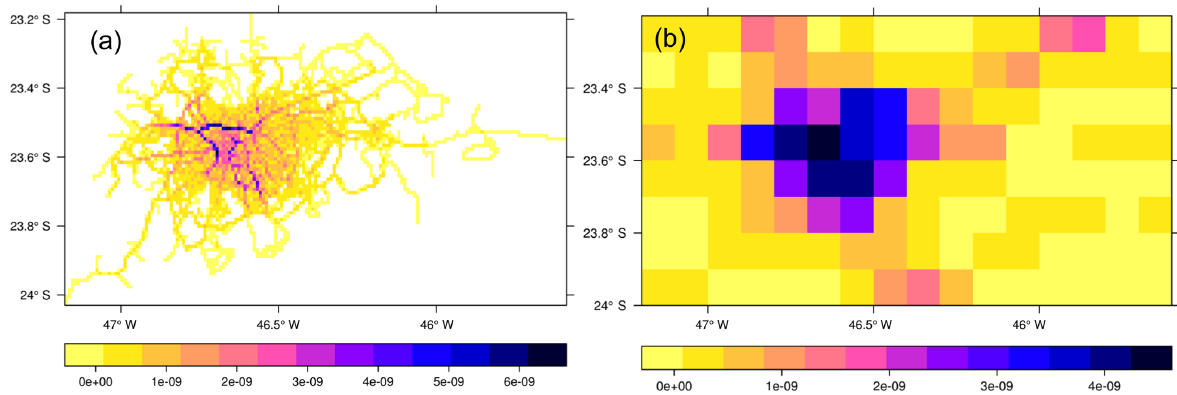
Figure 8. CO emissions (kgm − 2 s − 1 ) in MASP for (a) Monday at 00:00:00LT, estimated with VEIN; (b) the emissions of road transport for the same area from